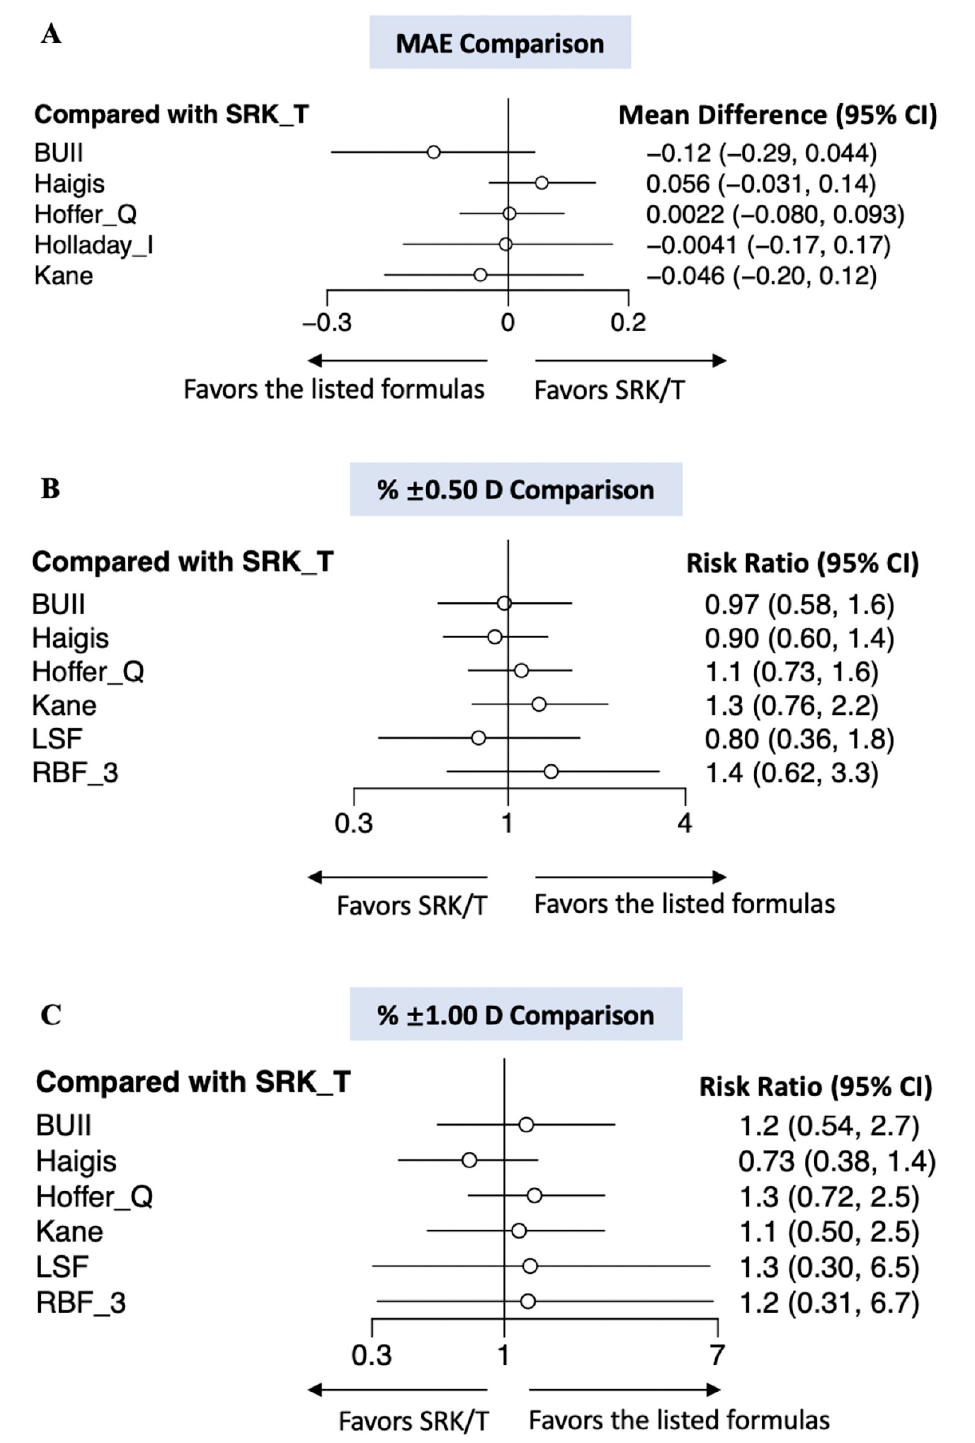
Fig 5. The forest plots of the pairwise comparison for MAE and % ± 0.50/1.00 D. The SRK/T formula was set as a reference and was compared with other listed methods. The pooled results for comparison of MAE, % ± 0.50 D and % ± 1.00 D were illustrated in A, B and C, respectively. SRK/T: Sanders, Retzlaff, Kraff/theoretical; BUII: Barrett Universal II; RBF: Hill-Radial Basis Function; LSF: Ladas Super Formula.